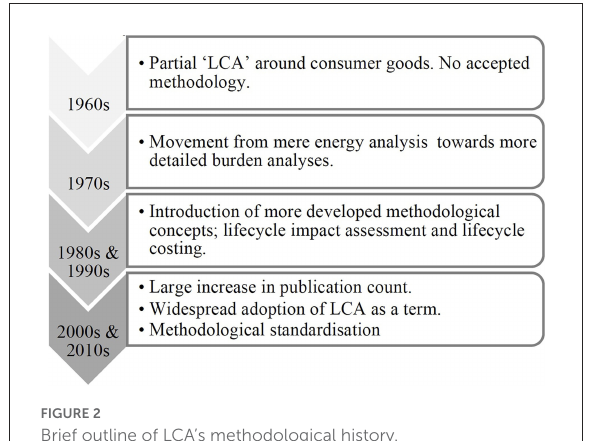
assessment” and year published of